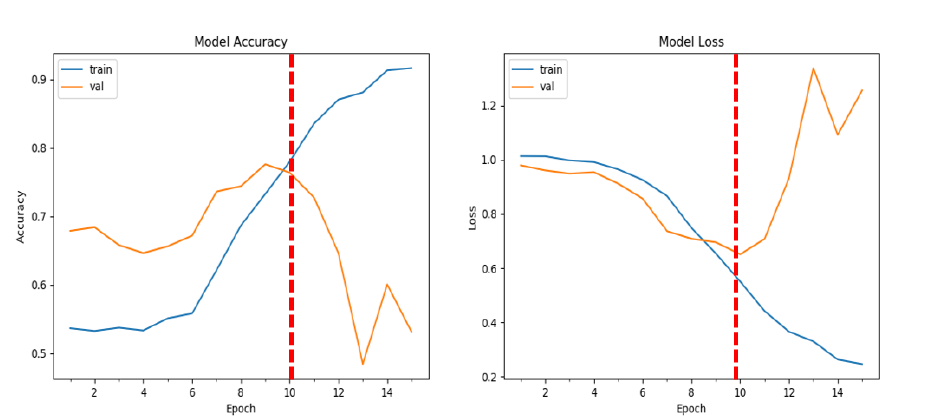
Figure 8. Accuracy and loss values of training and validation using 48 × 48 sized images (Setup I in Table 4).